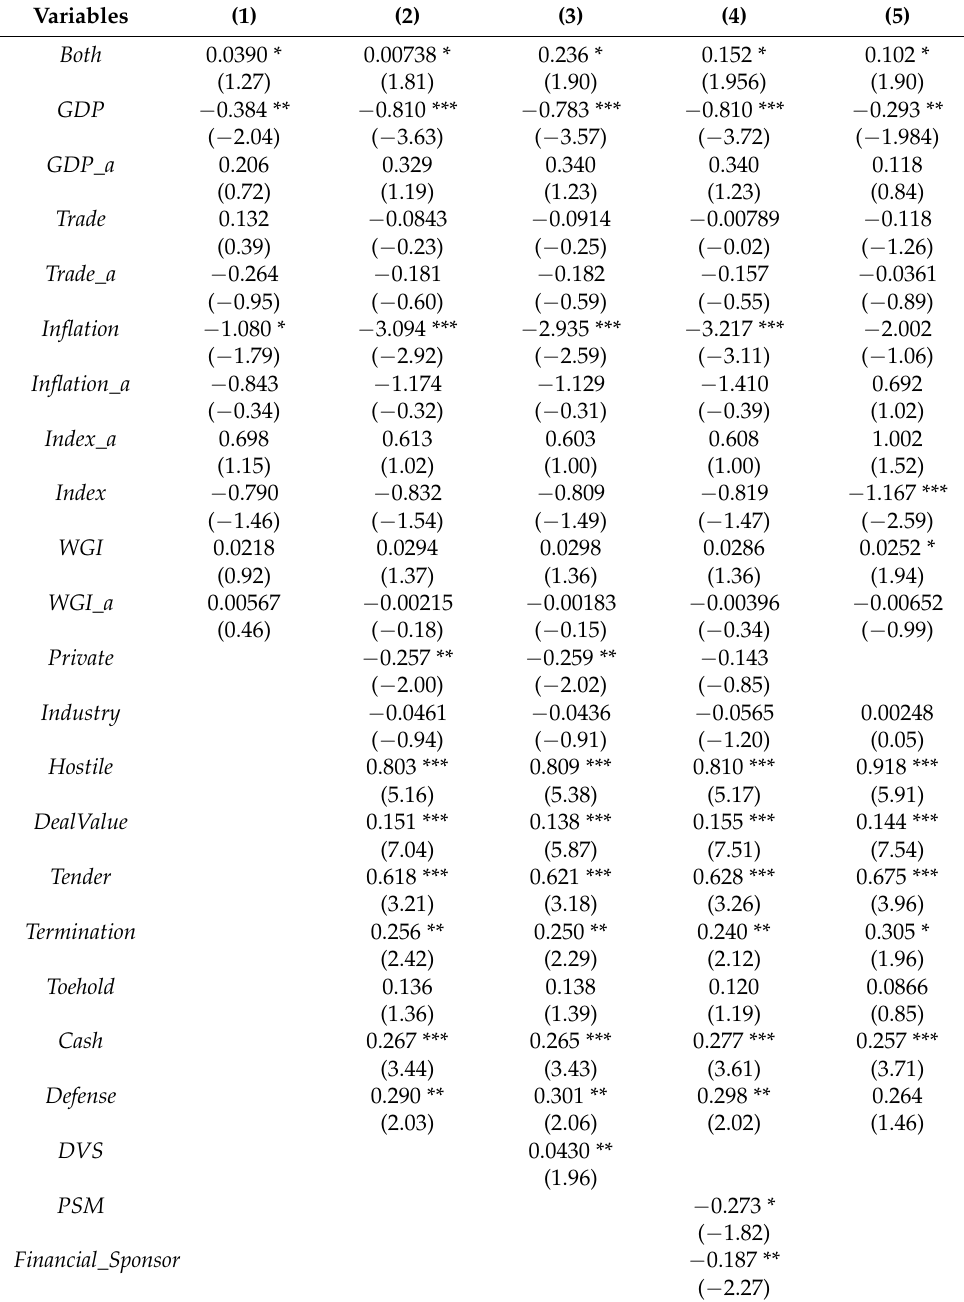
Table 9. This table presents the results of five probit regressions for a subsample of cross-border M&A deals. The dependent variable is Compete, an indicator variable that equals 1 if a deal received a competing bid and 0 otherwise. The main independent variable is Both, an indicator variable that equals 1 if social media is popular in both the acquirer and target countries. In addition to the control variables described previously, macro-economic variables for the acquiring country are